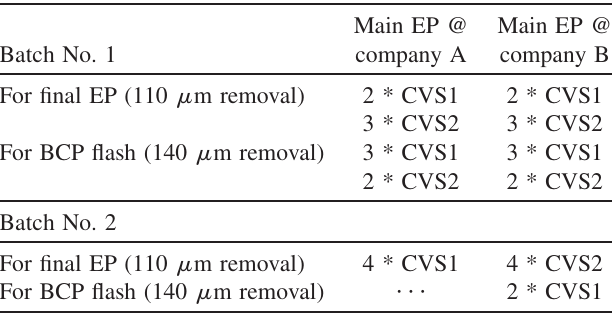
TABLE I. Distribution of resonators for main EP at industry.